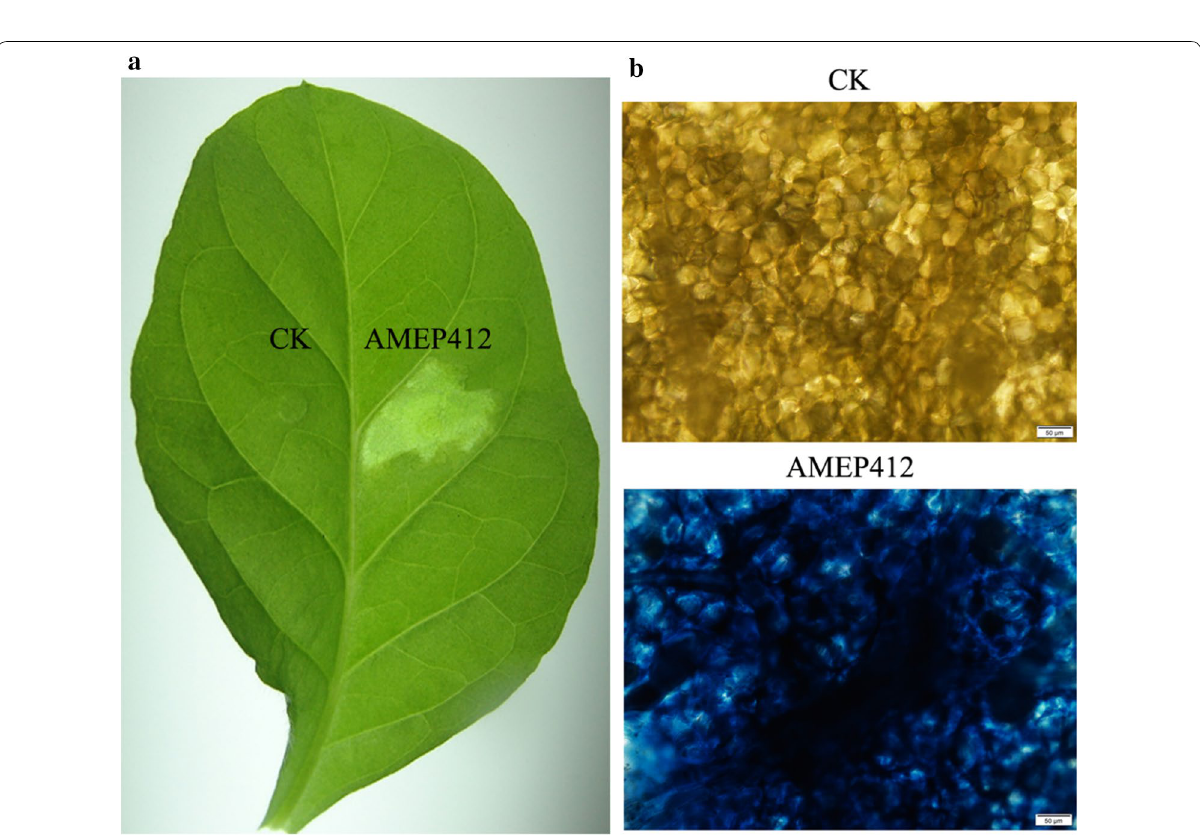
Fig. 2 AMEP412 induced HR in tobacco leaves. a HR lesion caused by AMEP412 in tobacco leaves. b Trypan blue staining of the HR areas infiltrated by AMEP412. Buffer treatment areas could not be stained by dye. AMEP412 induced cell death in infiltrated areas was stained blue. Scale bar